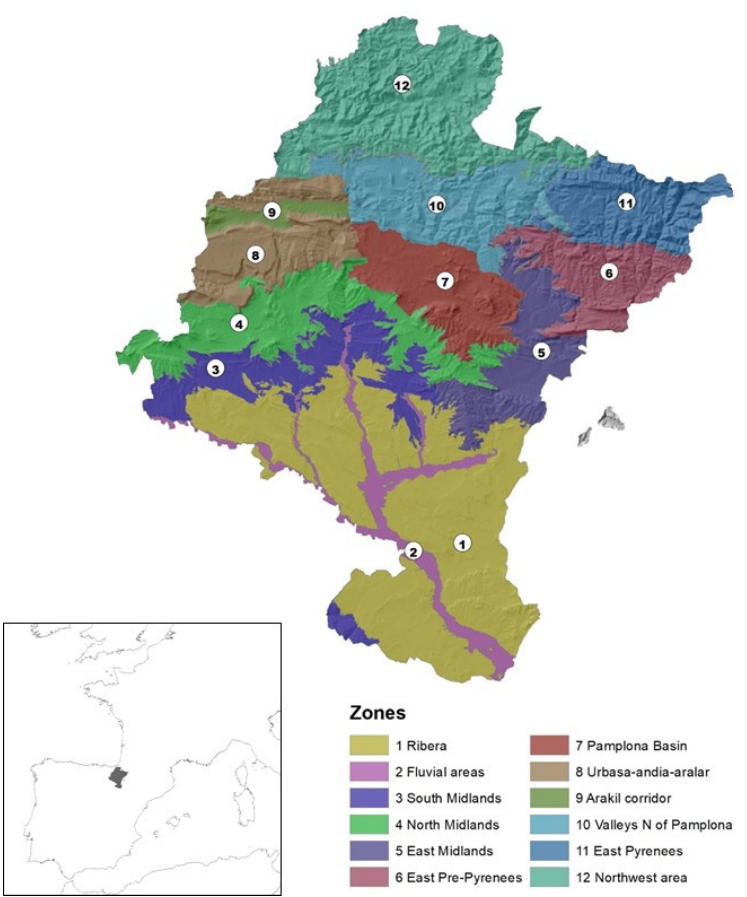
Figure 1. Location of the region of Navarre (bottom left) and homogeneous zones defined for this